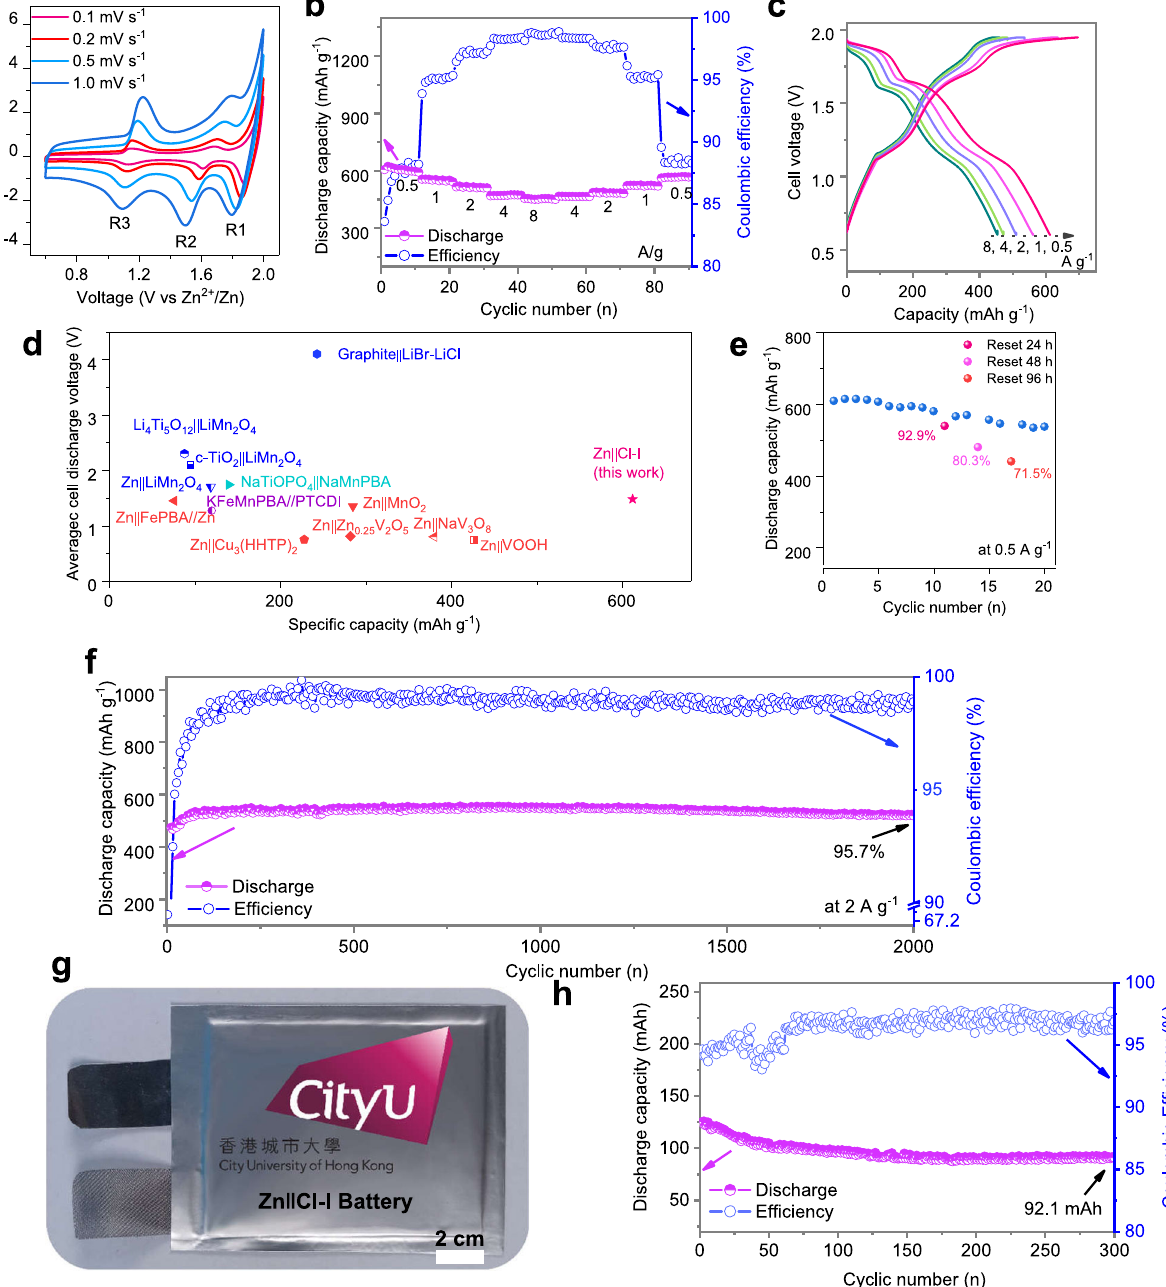
Fig. 5 | Battery performance of various Zn||Cl-I cells. a CV pro fi les and b rate performance of the Zn ǁ Cl-I pouch cell in 30m ZnCl 2 at 0.5A g I2 − 1 and 25°C. c Corresponding GCD curves at different currents based on the mass of iodine. d Comparison of the average voltage, capacity and cathode materials in different full battery systems, including Li + , Na + , K + , and Zn 2+ ion batteries, in which the corresponding performance data are exhibited in Supplementary Table 5 for